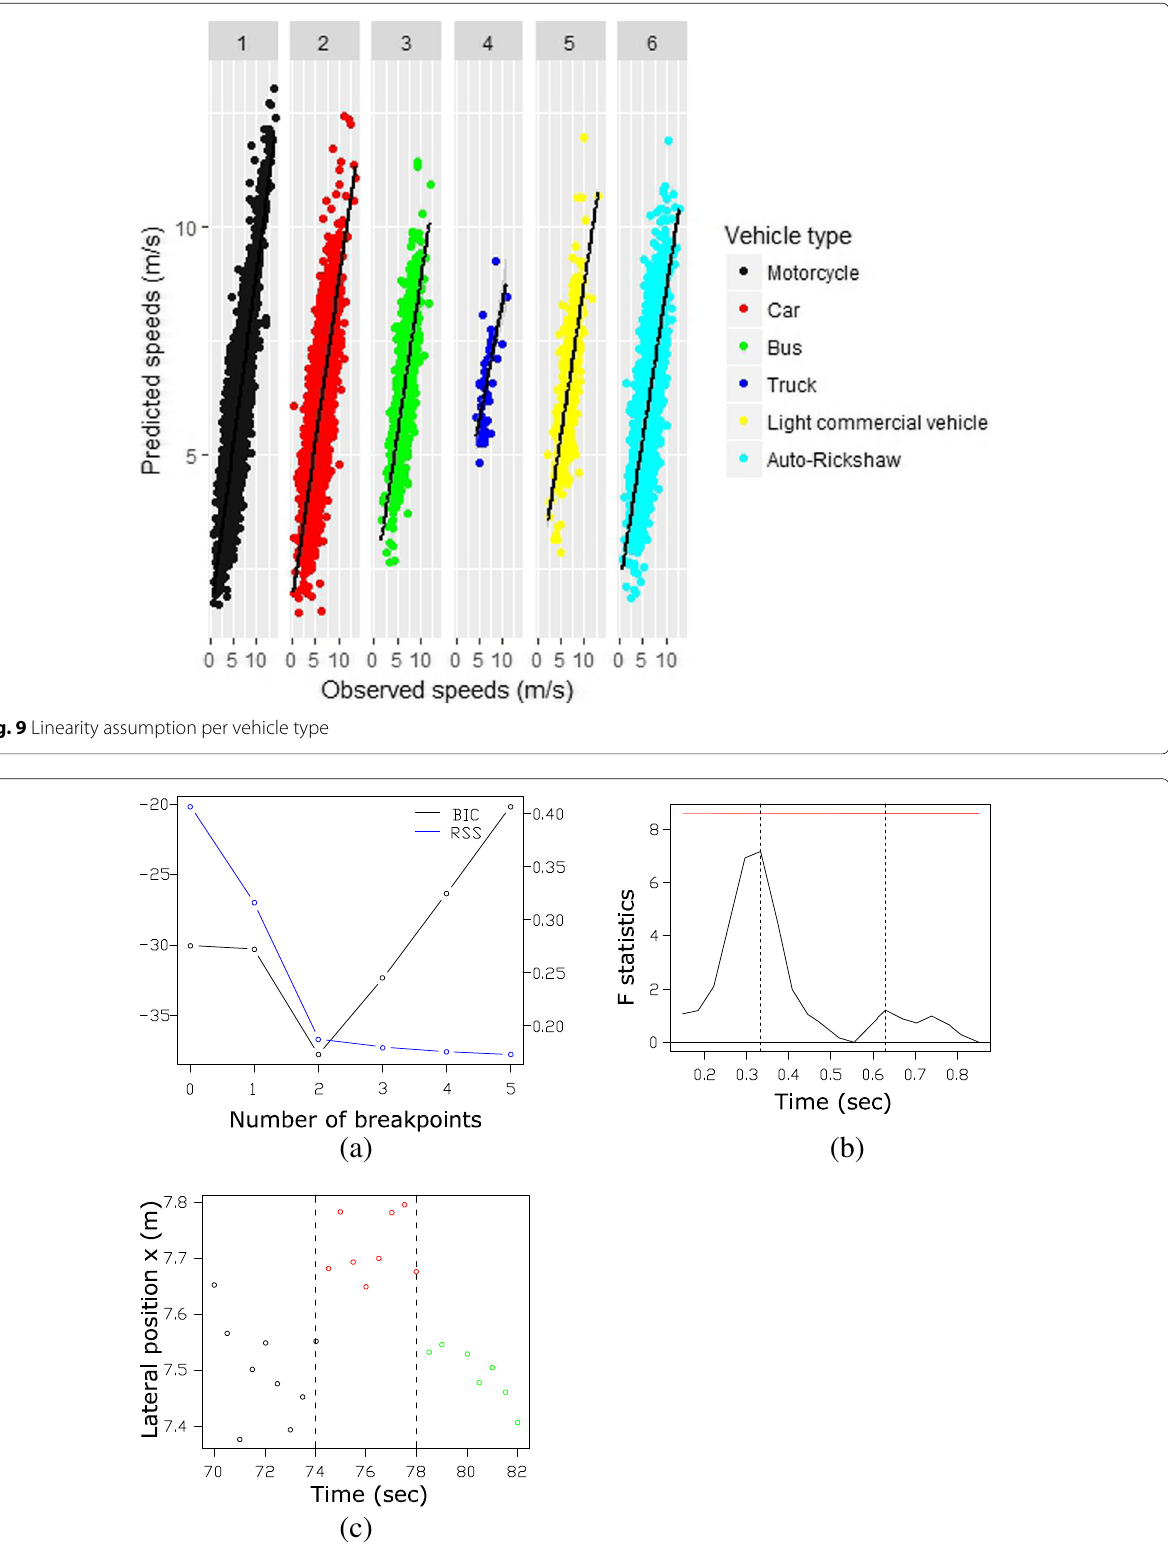
Fig. 10 a Optimal number of breakpoints using BIC and RSS for vehicle 109, b Breakpoints indicated by F-statistics for vehicle 109, c Lateral positions and breakpoints for vehicle